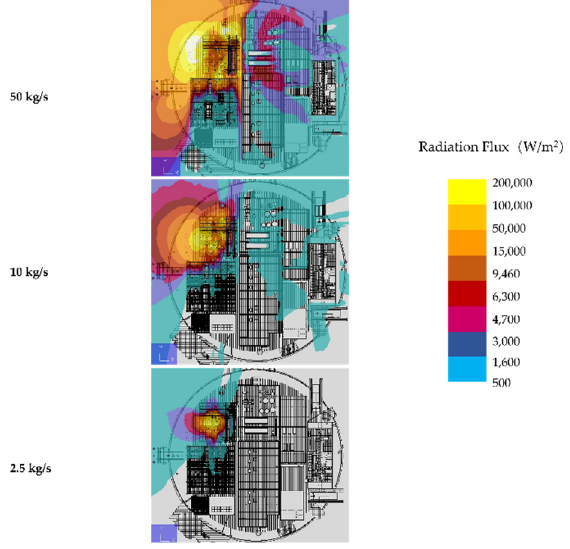
Figure 14. Leak 1 jet fire results—slice z = 50 m (process deck 2nd floor)—Radiation flux (W/m 2 ).